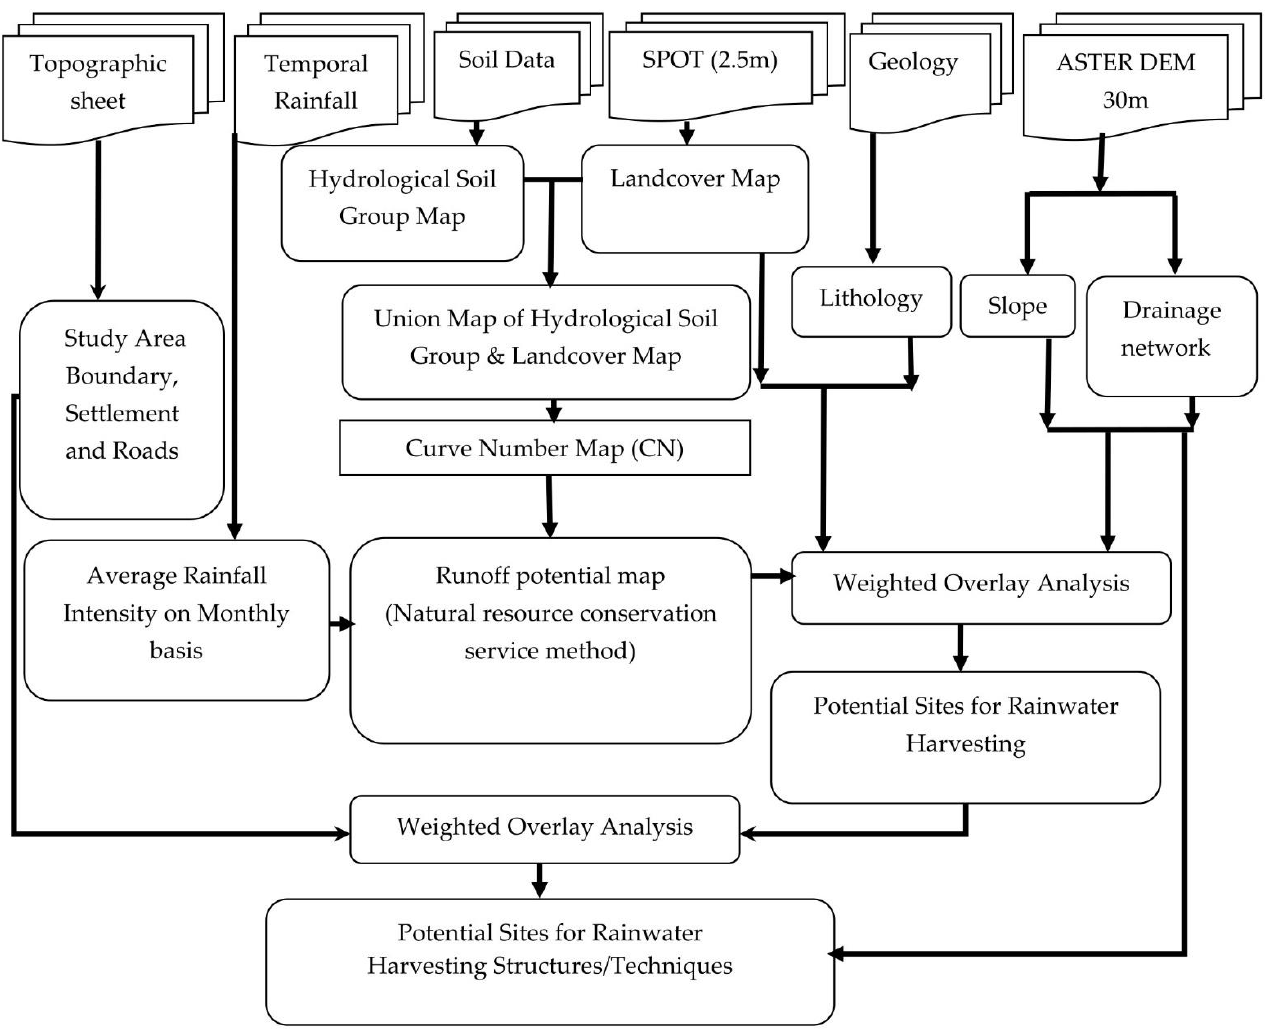
Figure 2. Conceptual methodology framework used to identify RWH potential site selection and potential sites for different RWH structures.